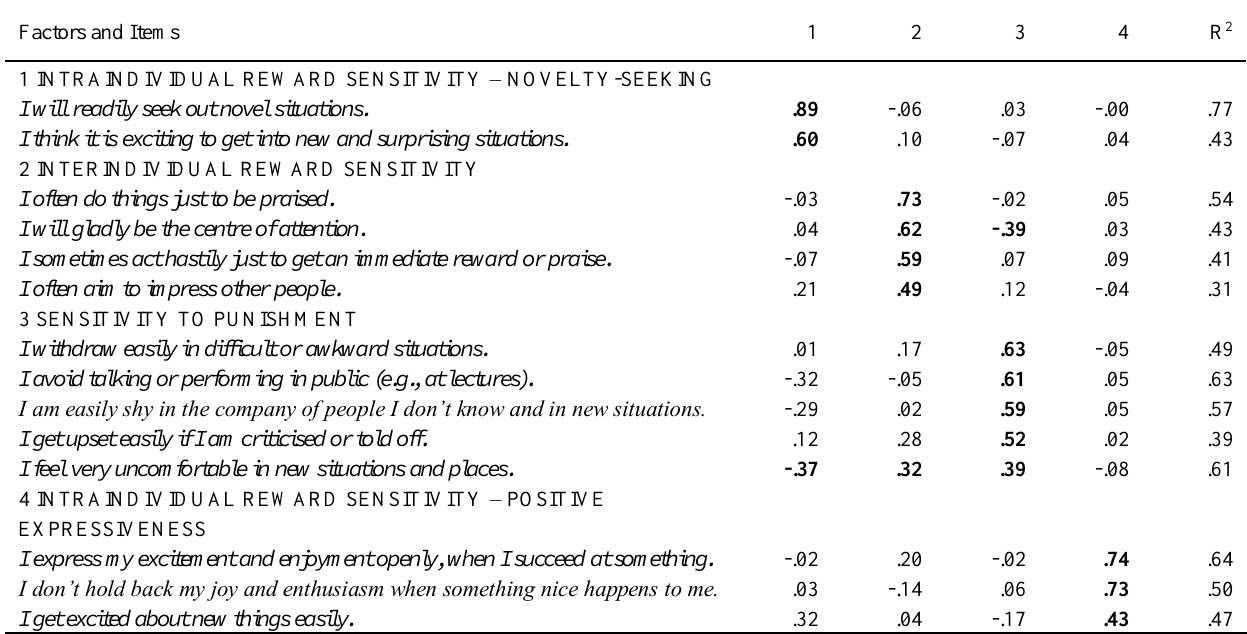
Factor Loadings (ESEM) of Reward and Punishment Sensitivity, and Explained Variance of Items (Study 1). Factors and